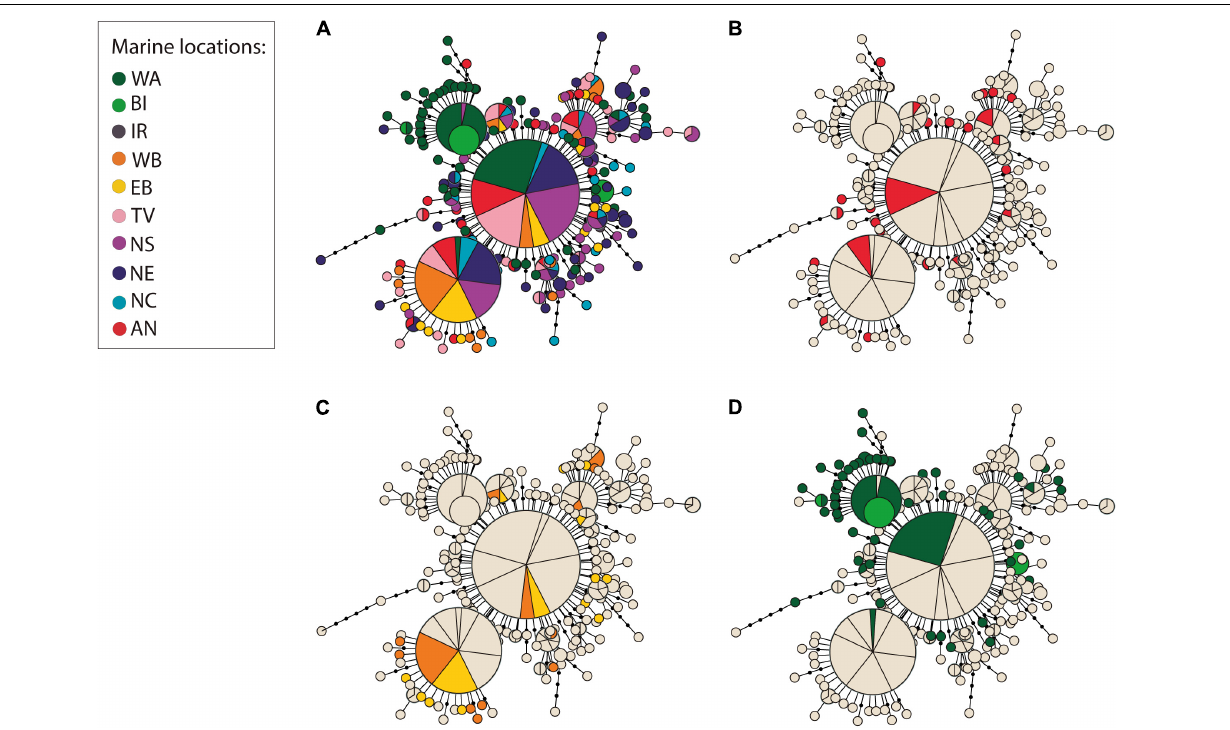
FIGURE 2 | Star-like haplotype genealogy based on complete mitogenomes of 545 samples of Atlantic cod. Only transversions (336) are depicted in this genealogy. (A) Haplotype genealogy colored by location. (B) Haplotype genealogy highlighting ancient specimens as a single group (in red; see Figure 1 and Supplementary Table 1 ; for specific distribution of sampling sites of ancient samples see Supplementary Figure 3 ). (C) Haplotype genealogy highlighting samples from the western (orange) and eastern (yellow) Baltic. (D) Haplotype genealogy highlighting western Atlantic (green) and Baffin Island (light green) specimens. Circle size is proportional to haplotype frequency. Black dots indicate intermediate haplotypes not found among the specimens and black lines connecting black circles correspond to mutation steps between